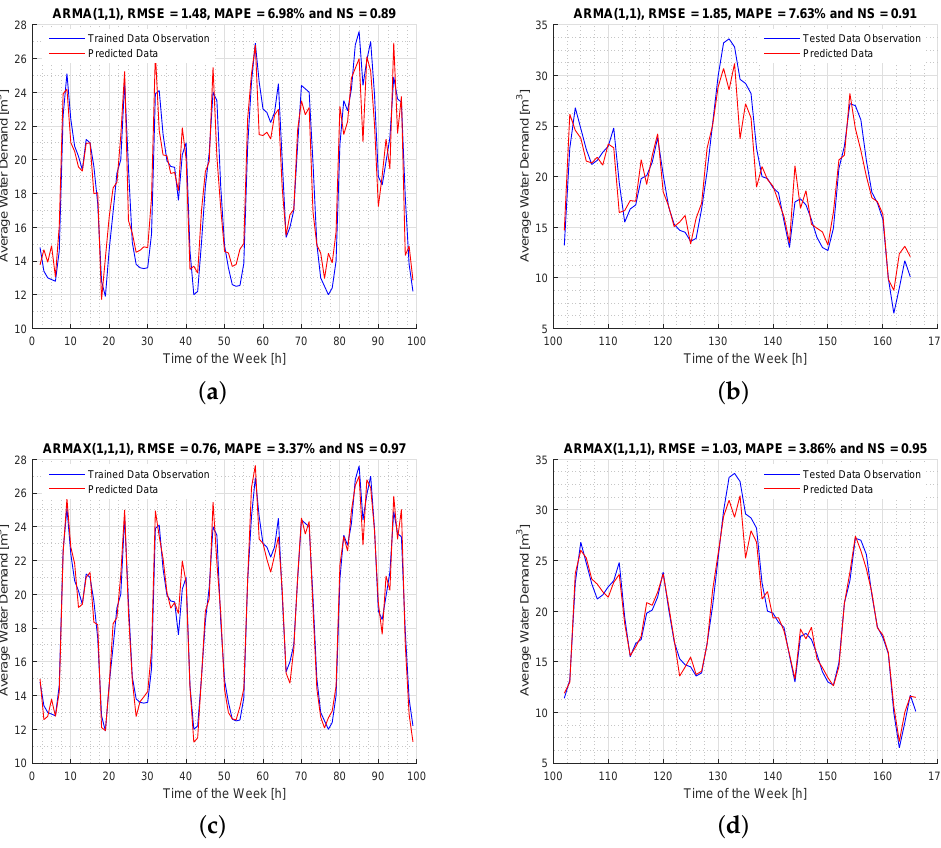
Figure 3. Forecasts generated using ( a , b ) ARMA model and ( c , d ) ARMAX model. Using AIC, the best model orders are ARMA ( p = 1, q = 1 ) and ARMAX ( p = 1, q = 1, b = 1 ) .